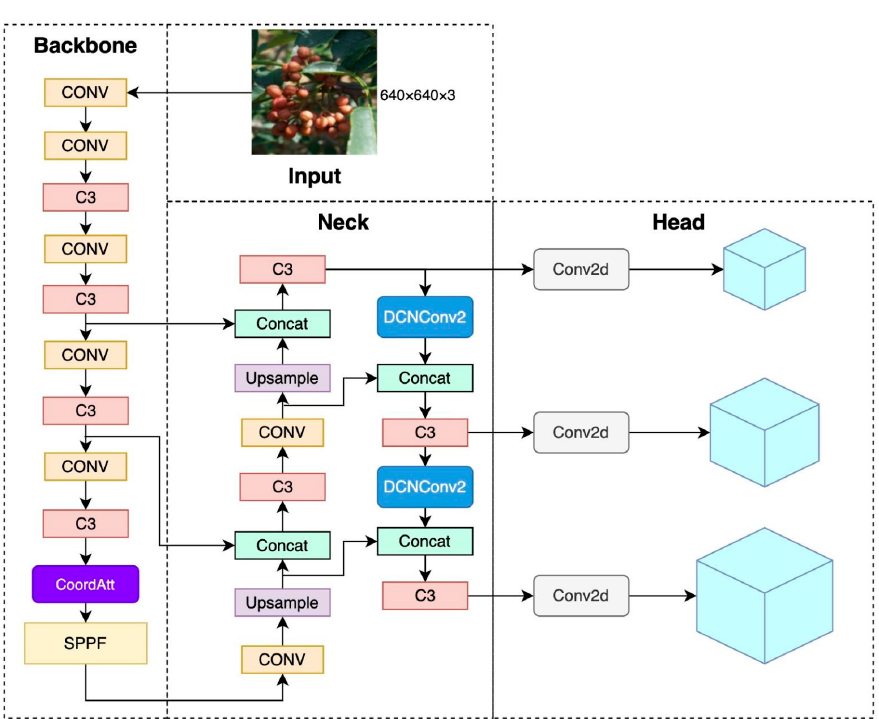
Figure 7. Improved YOLOv5 network map. Conv represents convolution, C3 represents a module consisting of three Convs and multiple bottleneck layers, SPPF refers to a spatial pyramid pooling-fast structure, Concat represents a feature fusion method of channel connection, Upsample represents up-sampling, and DCNConv2 refers to the deformable convolution module.